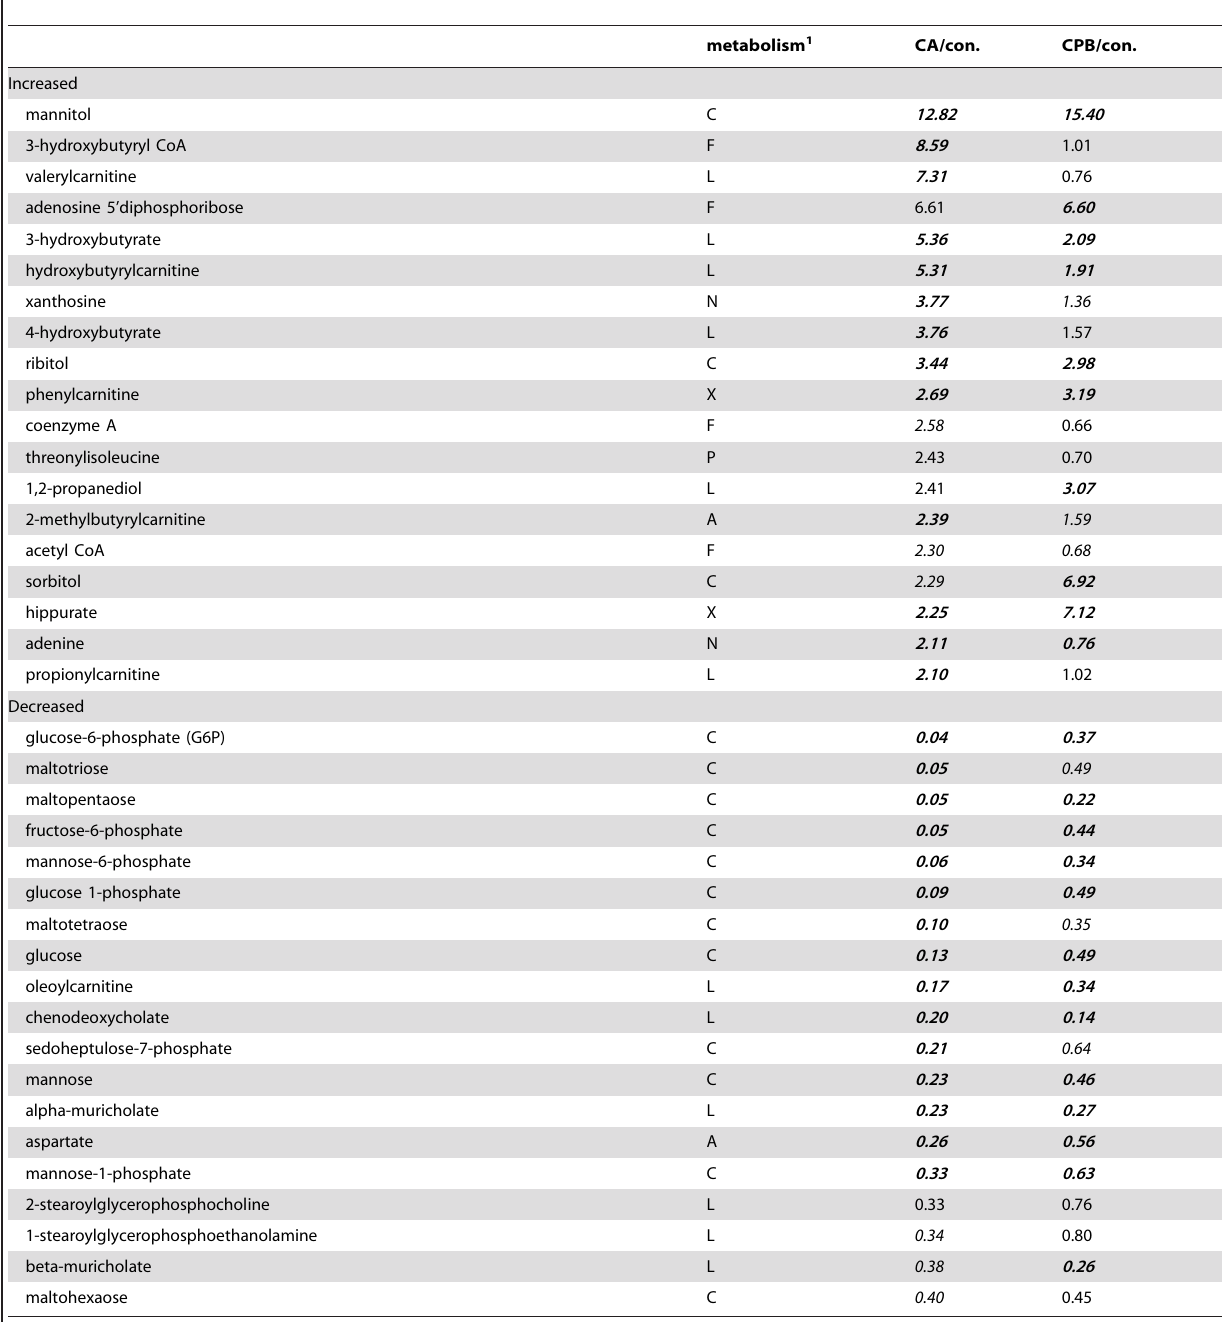
Table 3. Metabolic changes in heart tissue (n =5; bolditalic , p , 0.05; italic , 0.05 , p , 0.1).